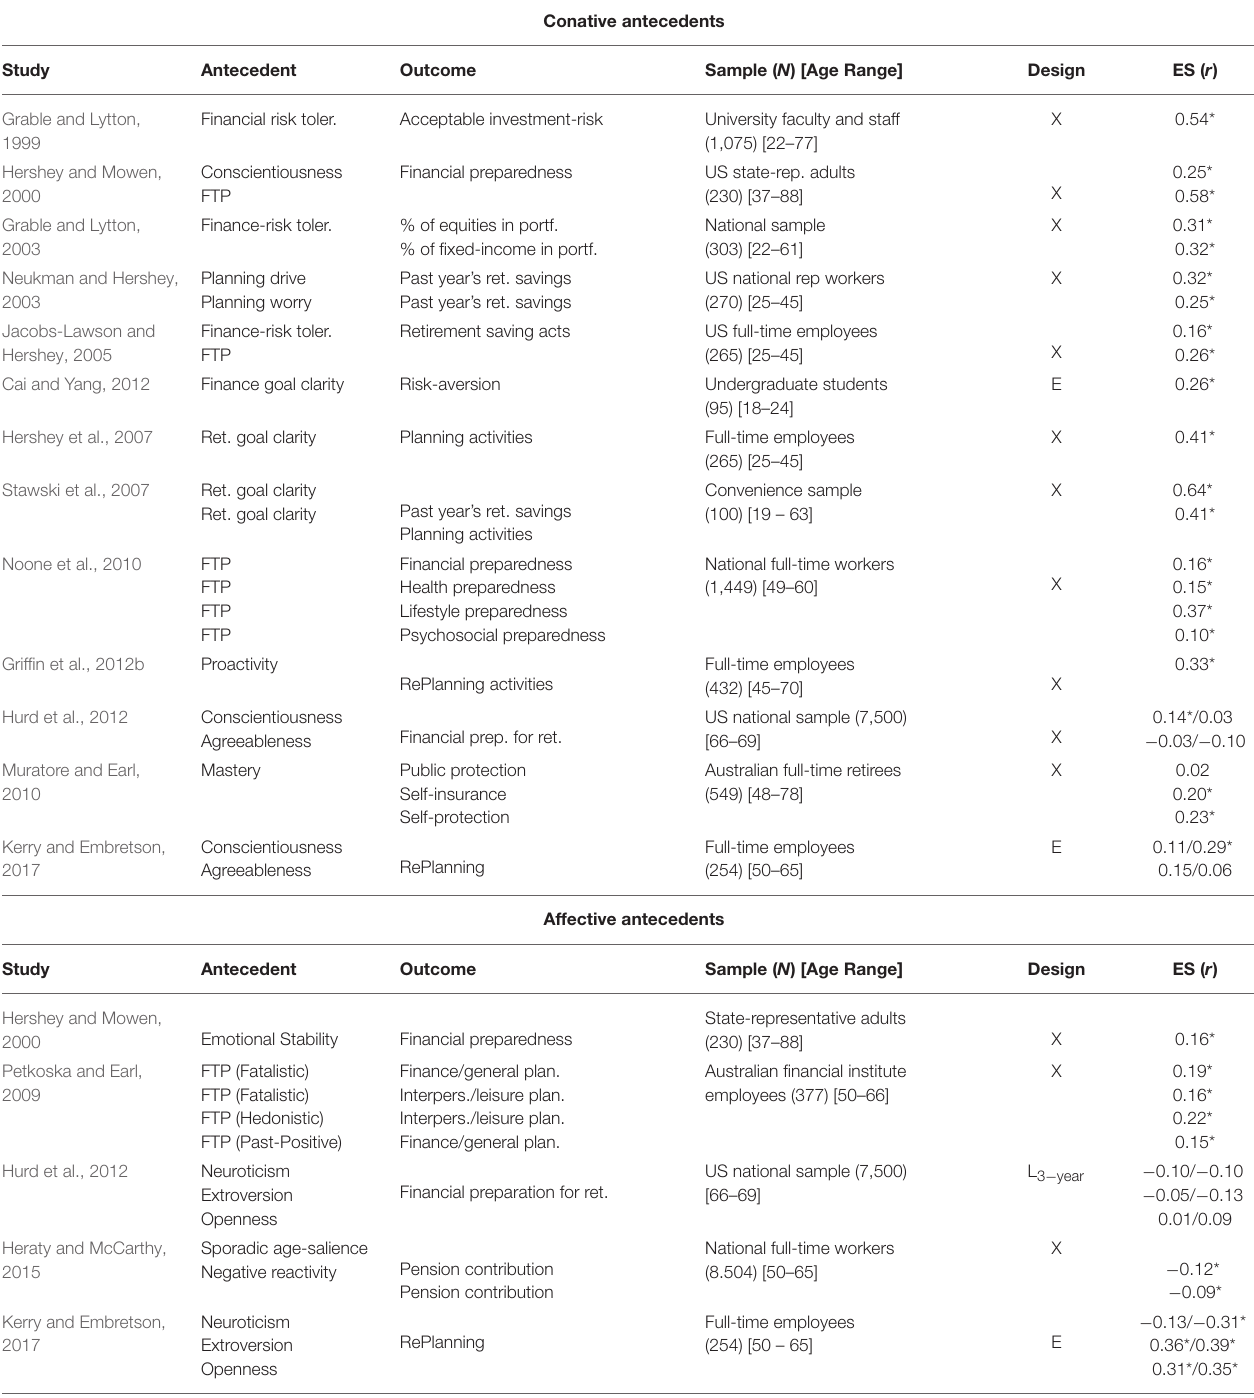
TABLE 3 | Summary study descriptives and effect sizes for conative and affective individual difference antecedents of retirement